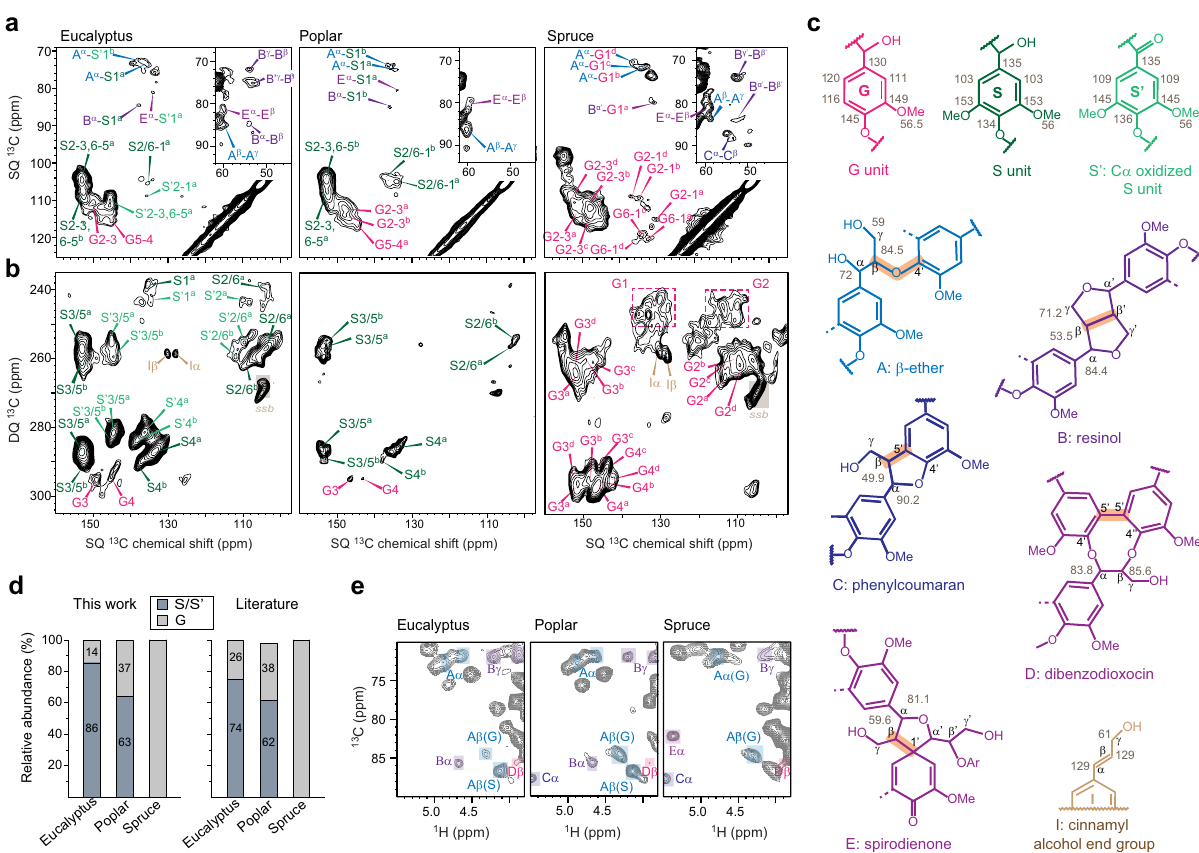
Fig. 2 Chemical structure of lignin determined using solid-state and liquid NMR. Lignin signals are resolved using the aromatic regions of a 2D 13 C- 13 C RFDR spectra and b 2D 13 C J-INADEQUATE spectra of intact plant cells of eucalyptus, poplar, and spruce. c The structure of lignin units and linkages resolved in wood stems. The standard abbreviations are given under each structure. The observed 13 C chemical shifts are labeled for each carbon site. Key inter-residual linkages are highlighted. d Composition of lignin units quanti fi ed using the integrals of one-bond cross peaks in 2D 13 C RFDR spectra (left panel) and using solution NMR as reported in the literature (right panel) 30,32,33,35,73,85,86 . Eucalyptus and poplar are S-rich while spruce is G-rich. Source data are provided as a Source Data fi le. e Representative lignin linkages detected by 2D 1 H- 13 C HSQC spectra of ball-milled biomass in d 6